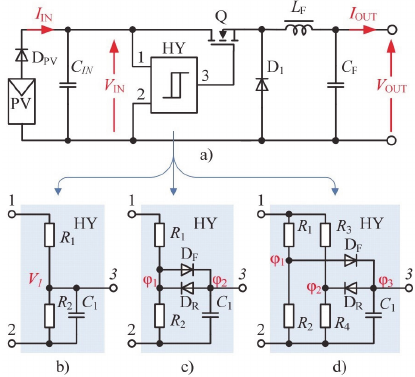
Fig. 2. Proposed optimizer functional diagram (a), different realization of hysteresis element HY